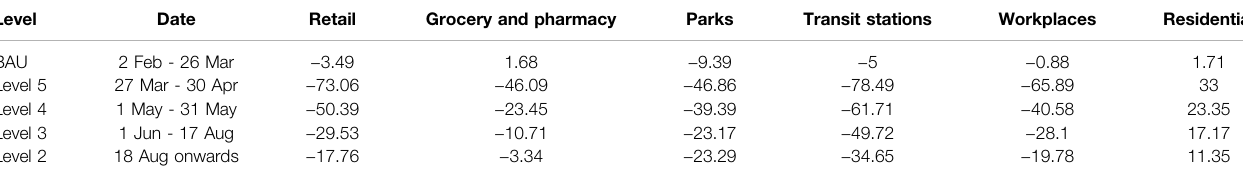
TABLE 3 | Average changes in population mobility over lockdown levels using the Google mobility data during